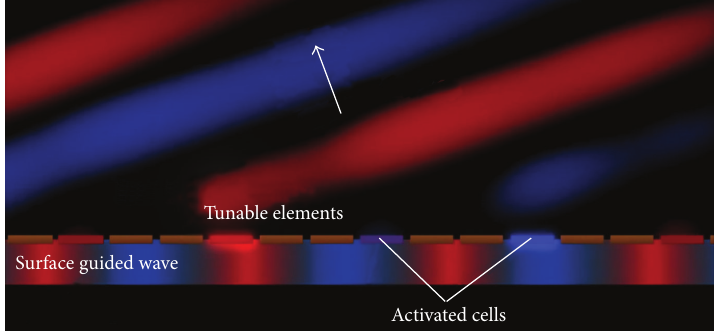
Figure 7: A snapshot of the wave radiating out from the microwave waveguide with selected cells activated [68] (used courtesy of Kymeta Corporation